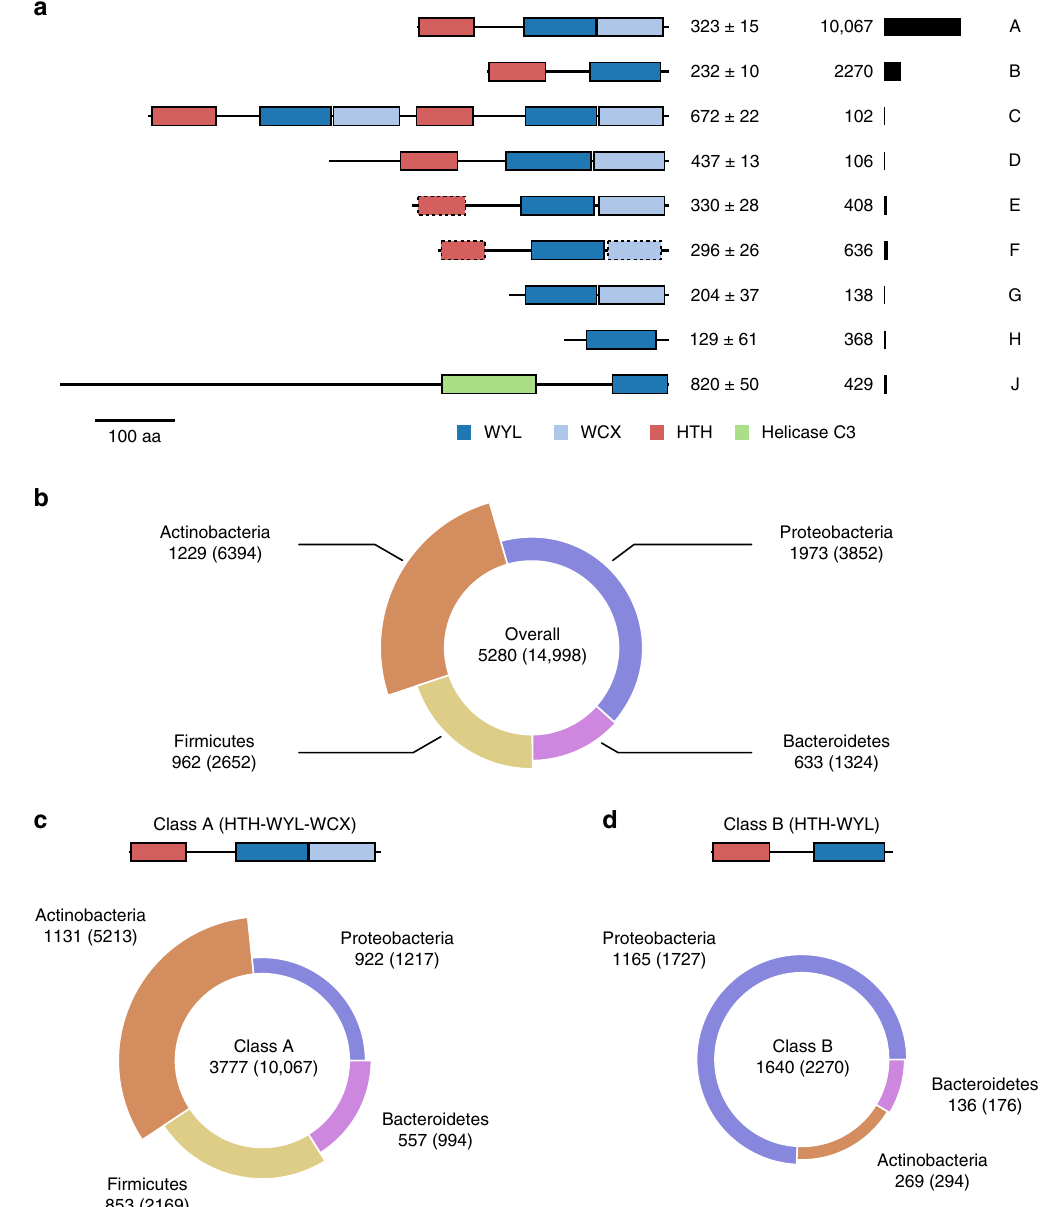
Fig. 6 Domain architectures and taxonomic distribution of WYL domain-containing proteins. a Domain architecture classes of WYL domain-containing proteins reveal a tight association with an N-terminal HTH domain. Median and standard deviation of protein length are given next to the domain architecture sketch of each class followed by the number of sequences. Domain architecture sketches are drawn to scale based on the median values of protein length, domain boundaries, and domain length. The scale bar equals 100 amino acids (aa). Domains with dashed line borders were assigned manually. For clarity, architectures with less than 100 sequences are not shown. b The taxonomic distribution of all WYL domain proteins shows a prevalent occurrence in Actinobacteria . c Class A, featuring the WCX domain located C-terminally of the WYL domain, is mainly found in gram-positive bacteria, namely Actinobacteria and Firmicutes , while ( d ) Class B, exhibiting only the WYL domain, is mostly found in Proteobacteria . The segment radian represents the number of unique species, while the thickness of the segment represents the average number of sequences per species within that taxonomic group. The number of species is given below the class labels with the number of sequences in parentheses. For clarity, taxonomic groups smaller than 1.5% of the total number are not shown. See also Supplementary Fig.